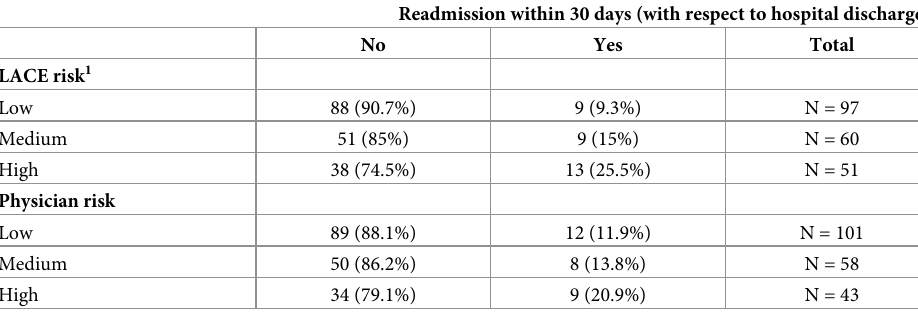
Table 4. Readmission rate according to LACE and physician assessment